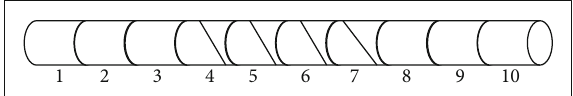
Figure 2: Schematic diagram of experimental core and fracture